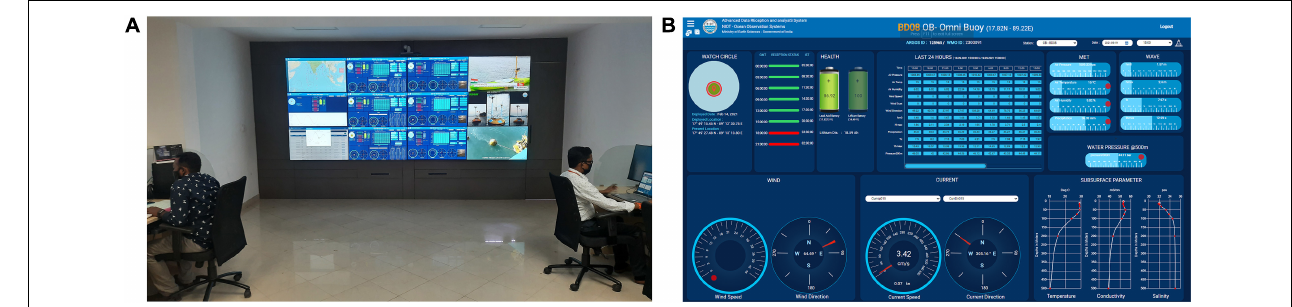
FIGURE 2 | (A) The data center being manned by limited manpower and enforcing social distancing during COVID-19 and (B) the dashboard of the in-house developed data management system ADDRESS.